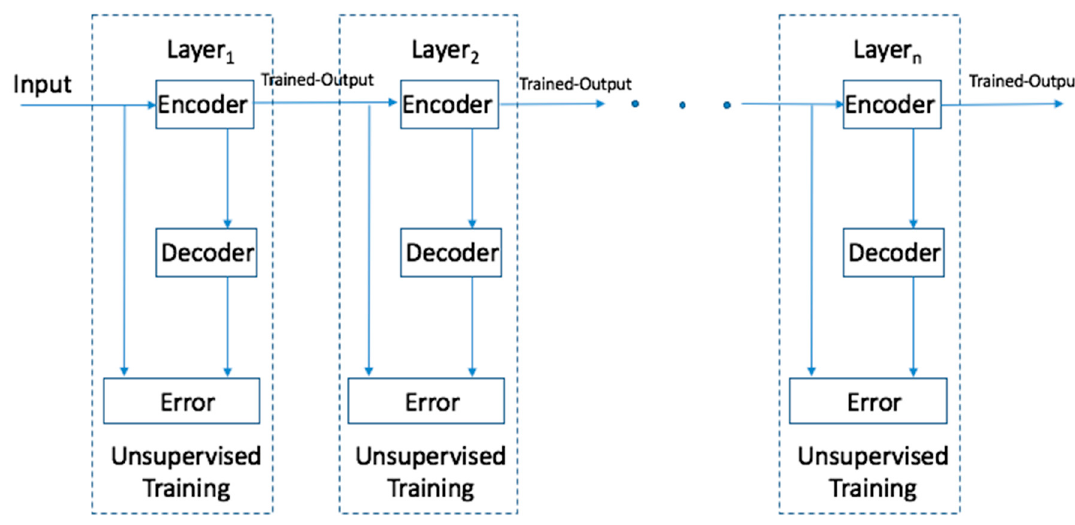
Figure 3. The demonstration of stacked autoencoder.